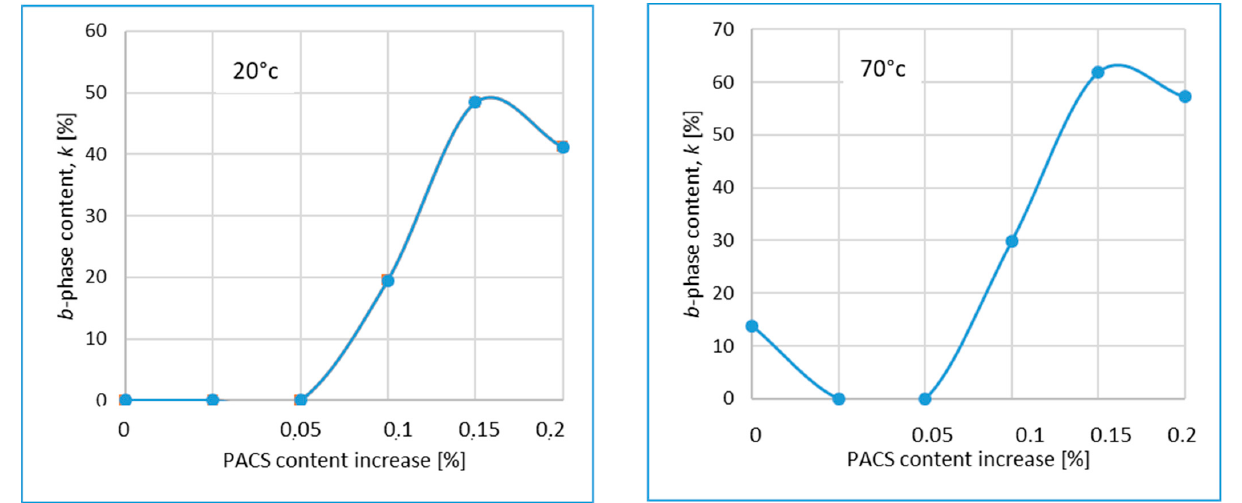
Figure 2. The value of k for samples modified with DMDBS and PACS for 20 °C and 70 °C.